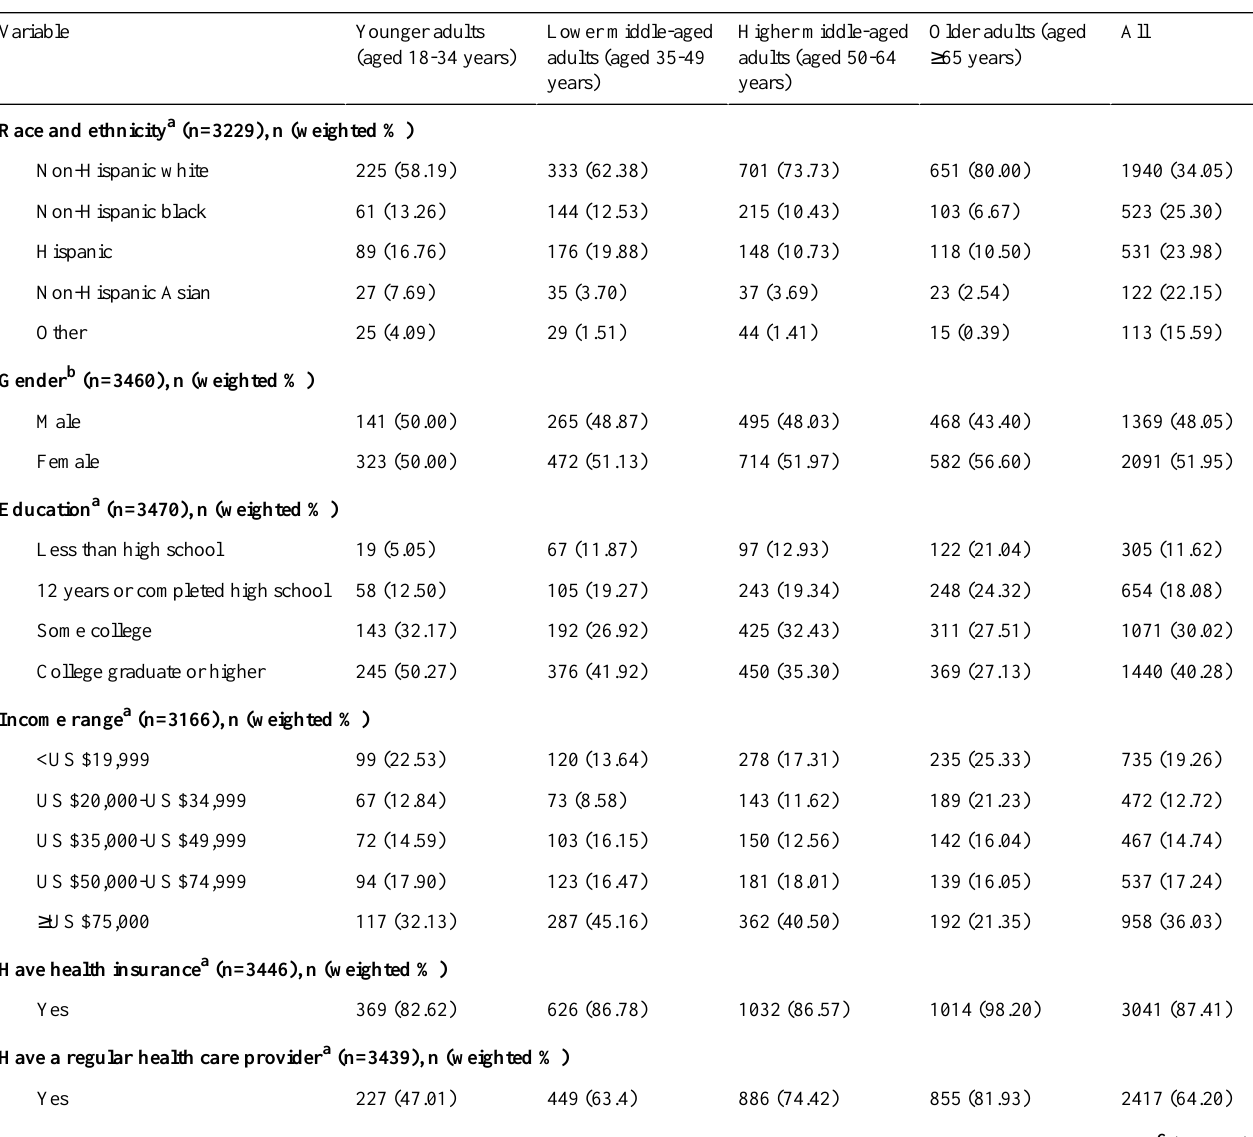
Table 1. Weighted percentage of individual characteristics by age